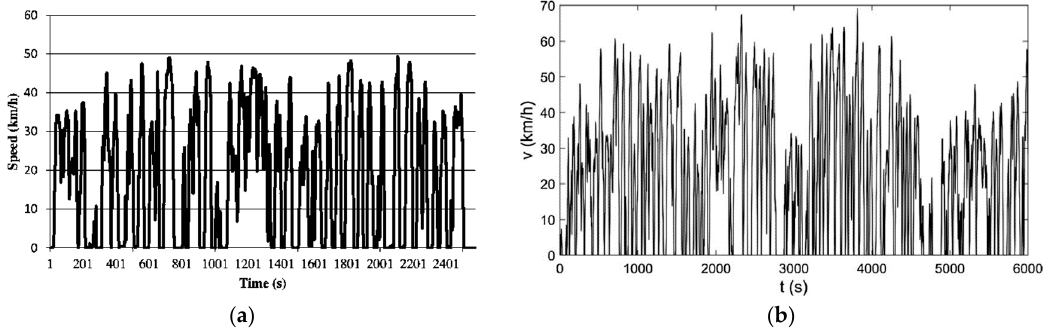
Figure 2. Examples of local driving cycles (LDCs) that could not be adequately extracted: ( a ) Celje [14]